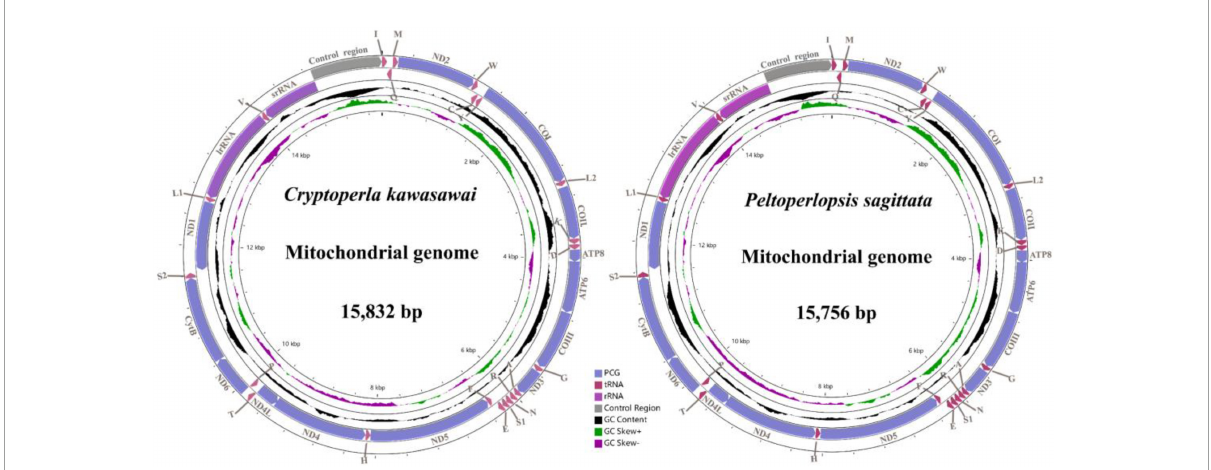
FIGURE2 Mitochondrial maps of Cryptoperla kawasawai and Peltoperlopsis sagittata . The direction of gene transcription is indicated by the arrows. tRNA genes are labeled according to single-letter International Union of Pure and Applied Chemistry-International Union of Biochemistry (IUPAC-IUB) abbreviations (L1, UUR; L2, CUN; S1, AGN; S2, UCN).